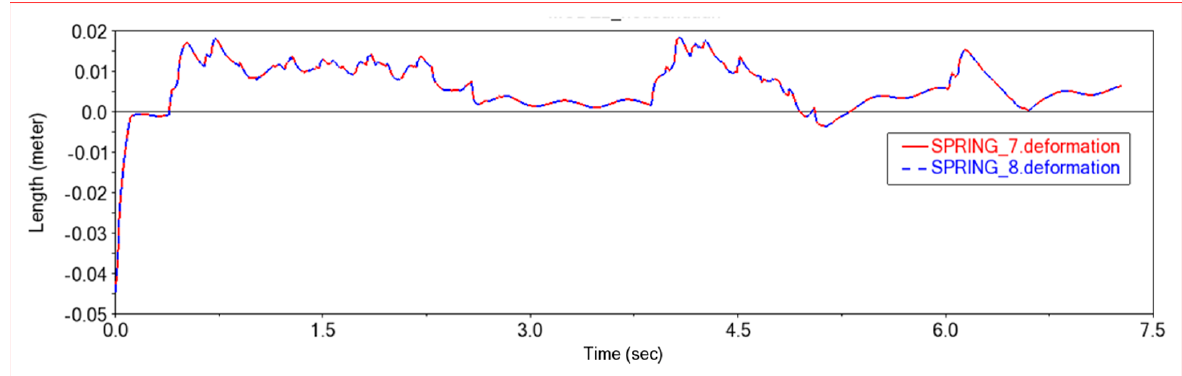
Figure 24. Deformation diagram of rear frame shock absorber. SPRING-7-Rear frame left shock absorber, SPRING-8-Rear frame right shock absorber.